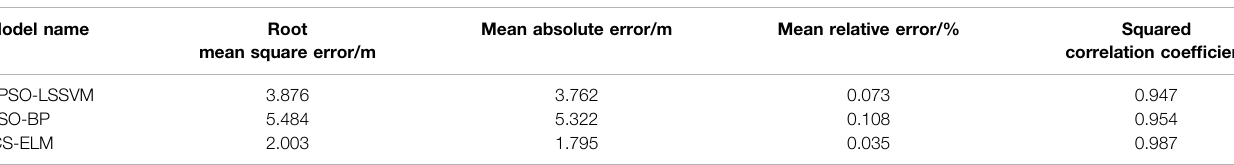
TABLE 2 | Prediction performance comparison of three models.